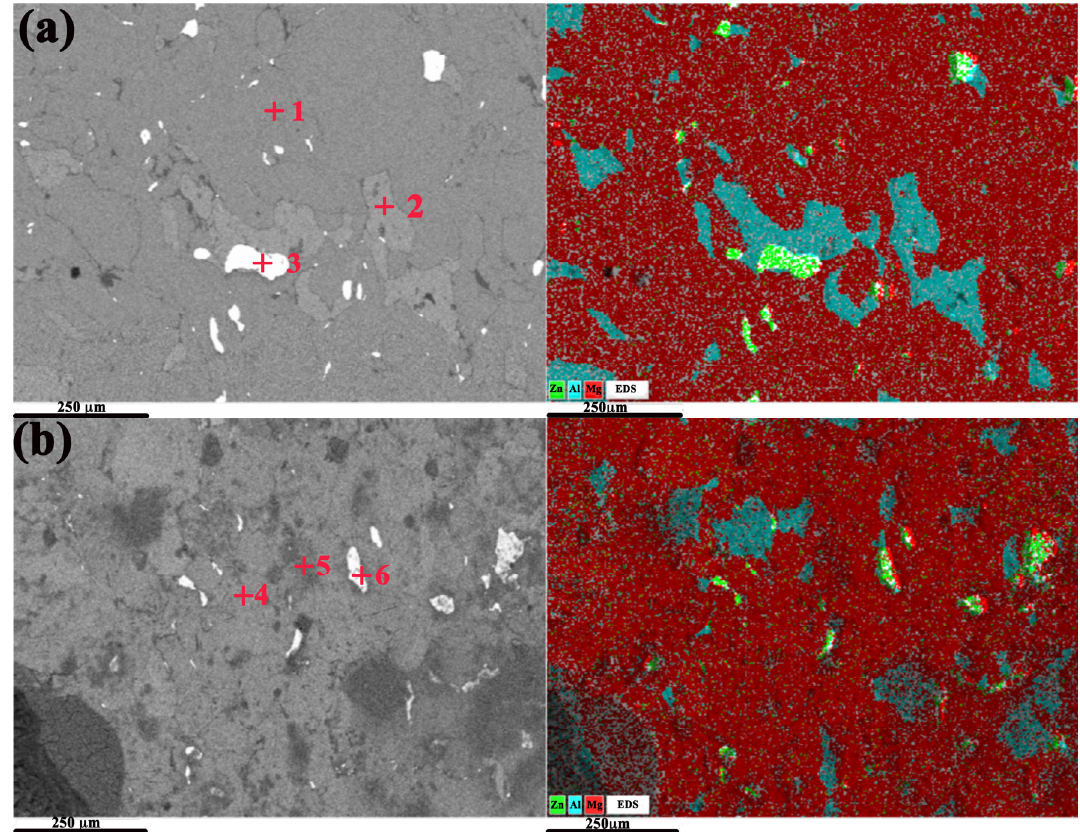
Figure 7. SEM (BSE) images and corresponding elemental mapping images of Mg-9Al-5Zn alloy foam: ( a ) before sintering treatment; ( b ) after sintering treatment. Table 2. EDS analysis results of positions marked in Figure 7.